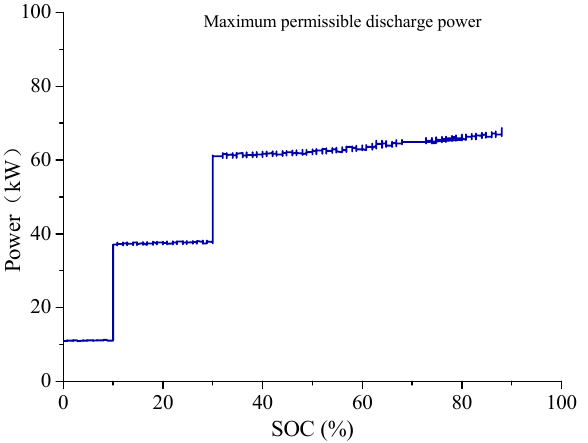
Figure 4. Maximum permissible discharge power of Li-ion batteries with different SOC 23 °C .